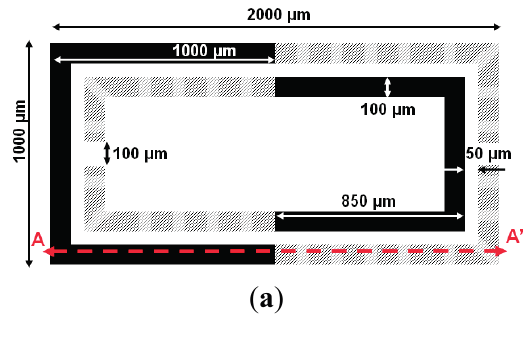
Figure 11. Tunable SRR based on cantilever-type RF-MEMS. ( a ) Top view with relevant dimensions. Black and grey parts correspond to anchors and suspended parts (including corrugations), respectively; ( b ) cross section in the up state; ( c ) cross section in the down state. The 500- μ m thick high resistivity silicon (HR-Si) substrate is electrically isolated from the anchor through a 1- μ m thick SiO 2 layer. From [22], reprinted with